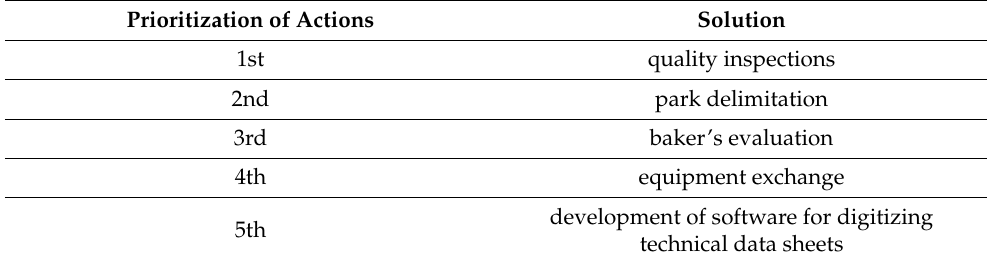
Table 4. Actions implemented through the final classification of highlighted